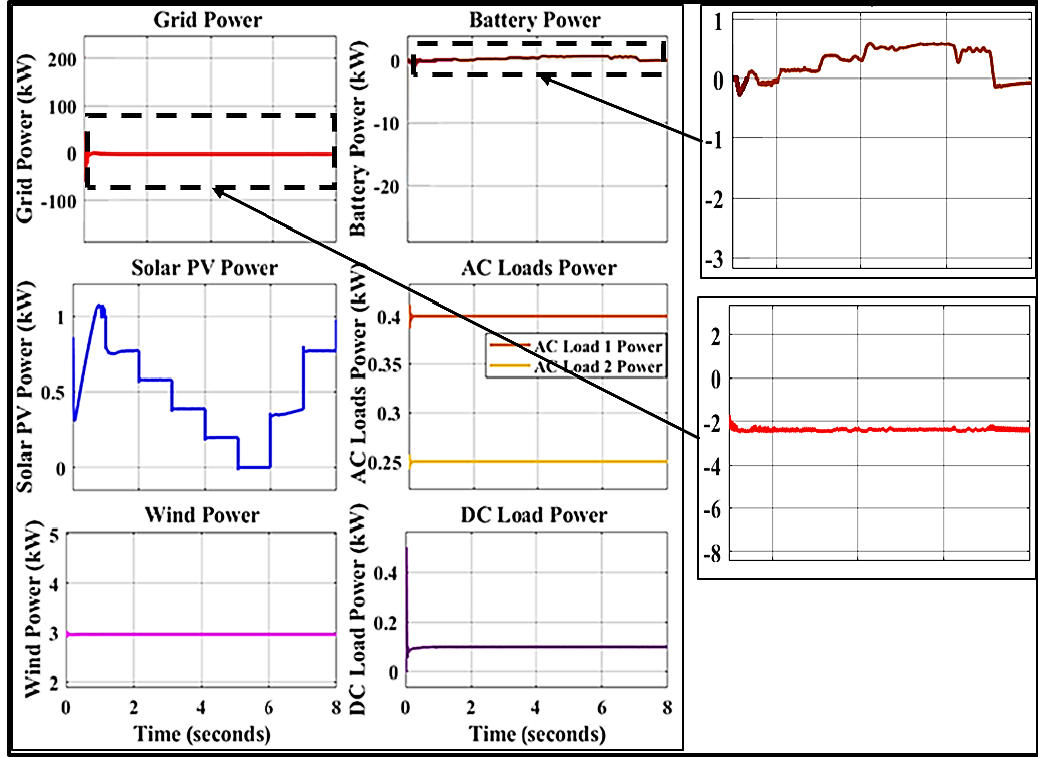
Figure 9 . The power of generation resources, main grid, and AC and DC loads under the first scenario.